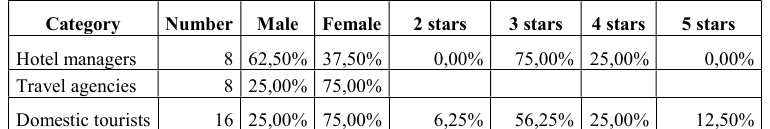
Table 1 . Summary of the